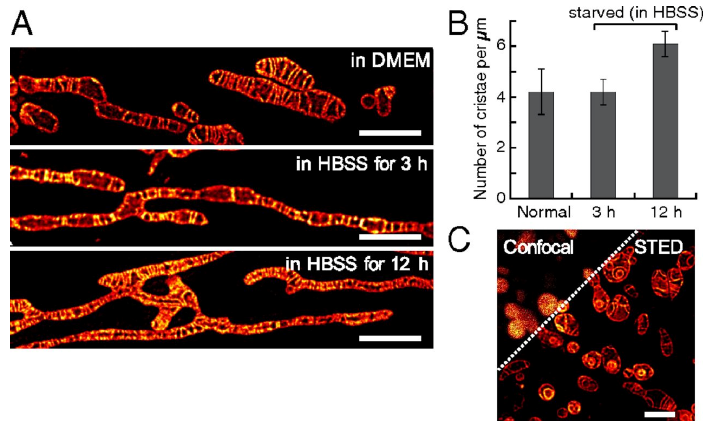
Figure 5. Morphological changes of the mitochondrial inner membrane captured by S stimulated emission depletion (STED) microscopy using 26 . ( A ): Deconvoluted STED images showing changes in the mitochondrial morphology; ( B ): Comparison of the number of cristae per micrometer of mitochondrial length before and after incubation for 3 and 12 h under starvation conditions; ( C ): STED image of cristae in HeLa cells, pretreated with 10 µM mitochondrial DNA replication inhibitor (ddC) for 5 days followed by staining with MitoPB Yellow. Reprinted with permission from ref. [62].